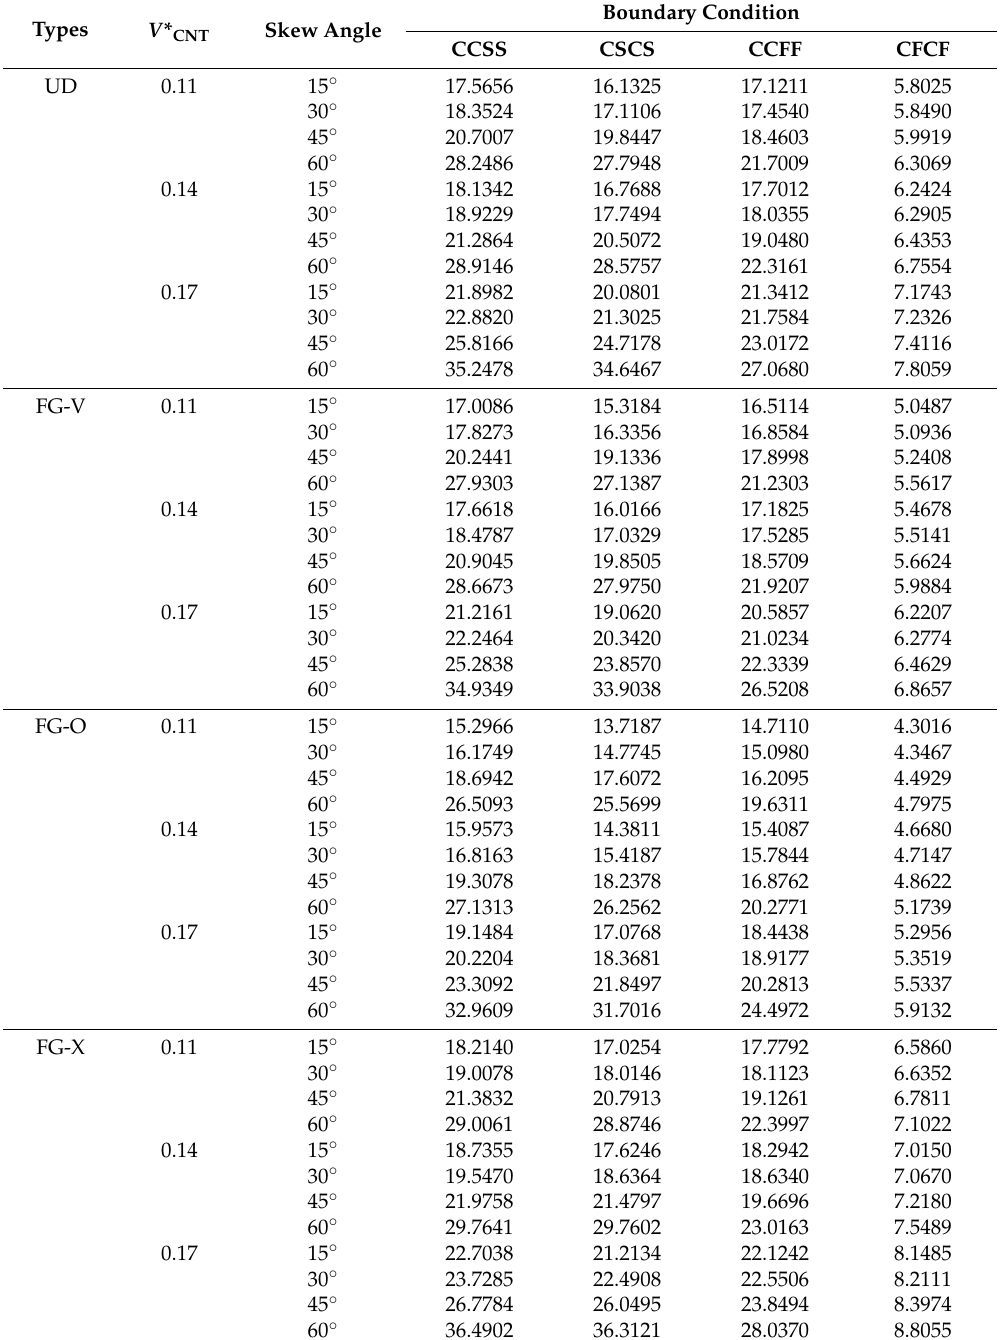
Table 12. Variation of fundamental natural non-dimensional frequency parameters of FG-CNT- reinforced rhombic plate.